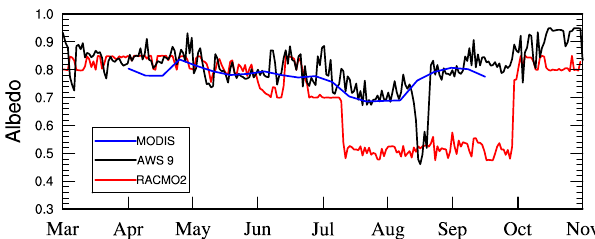
Fig. 3. Surface albedo for the year 2006 at S9 along the K-transect. Black line shows AWS measurements, red line shows RACMO2 results using the previous, density-dependent albedo scheme, and blue shows MODIS-derived albedo.